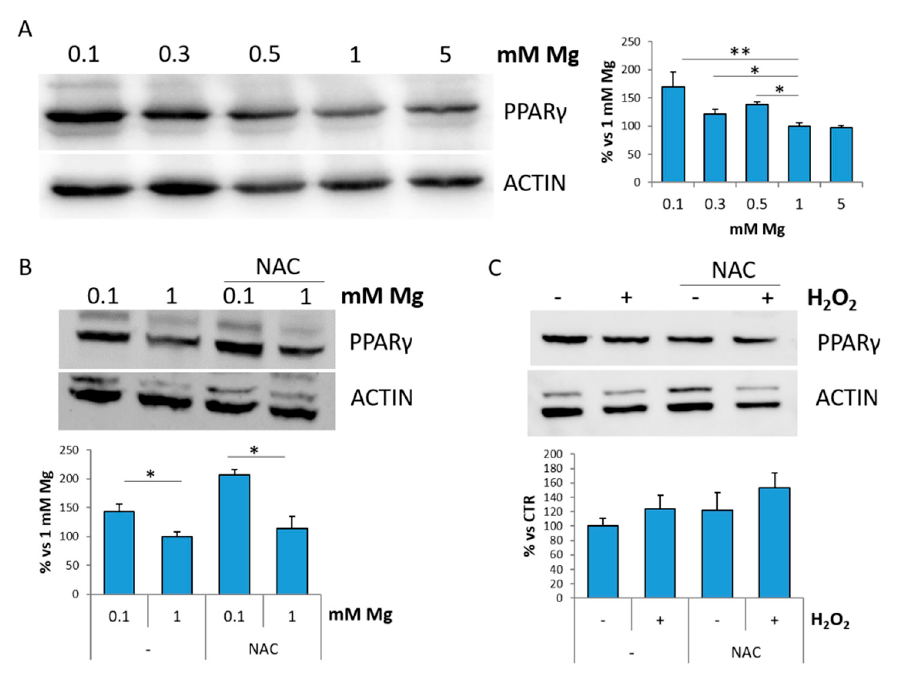
Figure 4. Low magnesium induces PPAR γ . ( A ) HUVEC were cultured in low (0.1, 0.3, 0.5 mM), physiological (1 mM) and high (5 mM) extracellular Mg for 24 h. ( B ) HUVEC were cultured in 0.1 or 1 mM in the presence or in the absence of NAC (5 mM) for 24 h. ( C ) HUVEC were treated with H 2 O 2 (200 µ M) for 30 min in the presence or in the absence of NAC (5 mM) and then maintained in culture for 24 h. Cell extracts were processed for Western blot using antibodies against PPAR γ . Actin was used as a control of loading. A representative blot is shown. Densitometry (right panel) was performed on three different blots by Image J. * p ≤ 0.05 and ** p ≤ 0.01.